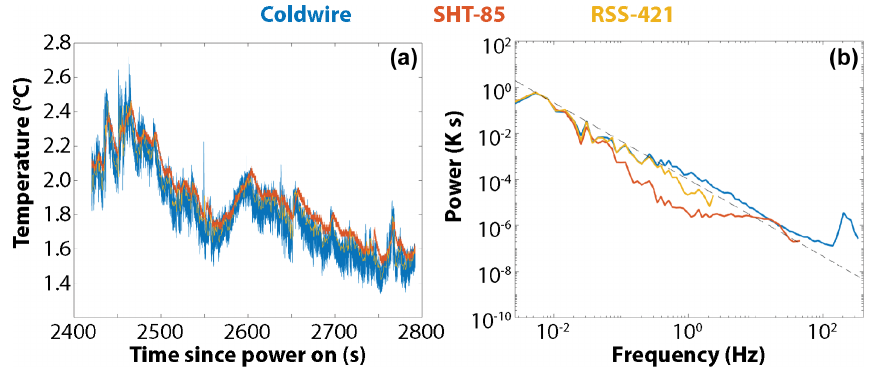
Figure 3. A time series (a) of temperatures measured during level flight by the DH2 during the MOSAiC campaign. Included are temperature values measured by the cold-wire sensor (blue), RSS-421 sensor (yellow), and SHT-85 sensor (red). The power spectral density of the temperatures recorded by each sensor are included on the